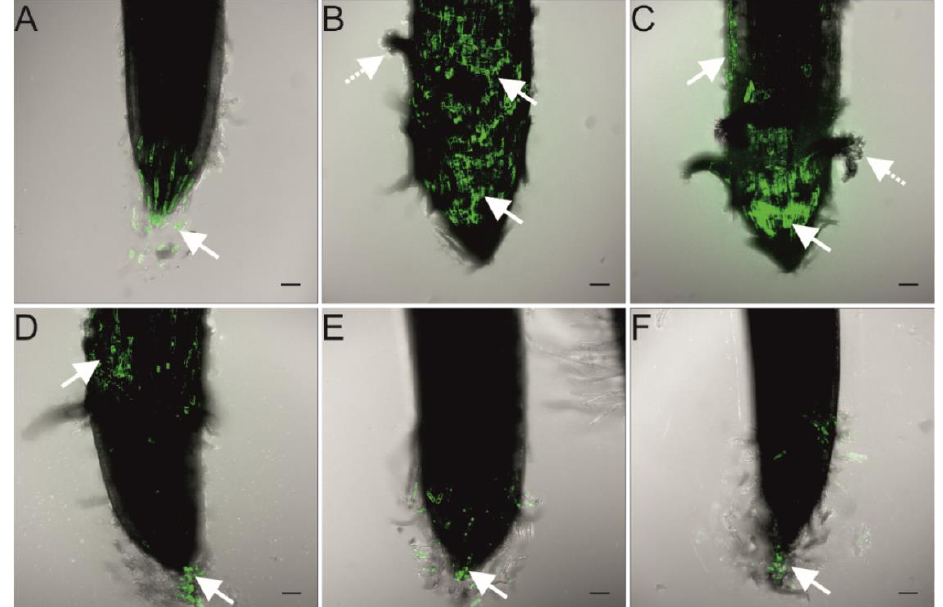
Figure 3. Determination of cellular reactive oxygen species (ROS) by H 2 DCF-DA assay in the wheat root tips after 3 days of seedling development in Ag NPs with sizes of 0 ( A ), 10 ( B ), 20 ( C ), 40 ( D ), 60 ( E ), and 100 nm ( F ). Scale: the length of the horizontal white bars equals 100 µm. The white arrows show the higher level of ROS generation.